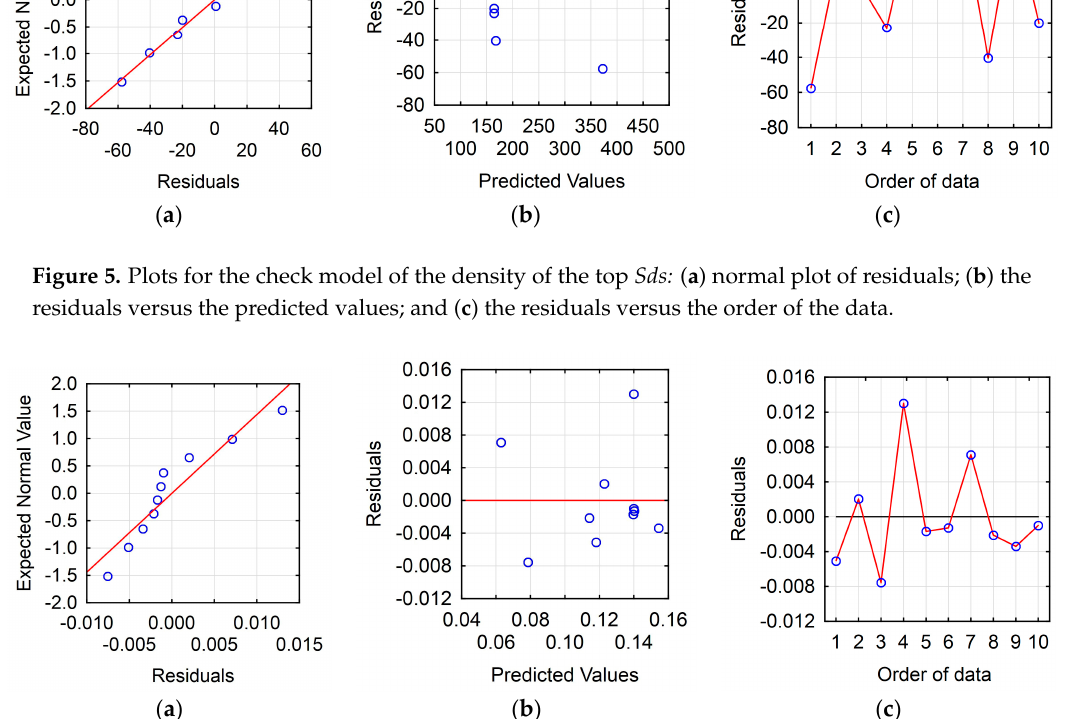
Figure 6. Plots for the check model of the arithmetic mean curvature to the top Ssc : ( a ) normal plot of residuals; ( b ) the residuals versus the predicted values; and ( c ) the residuals versus the order of the data.